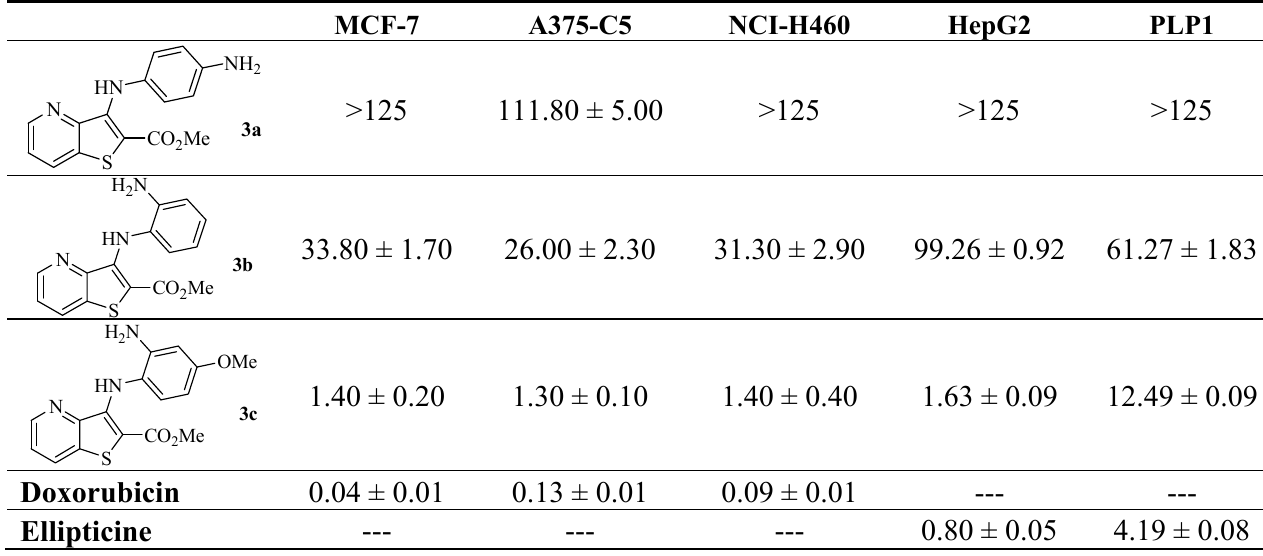
Table 1. GI values a (  M) for the aminodi(hetero)arylamines 3a – c and for the controls 50 doxorubicin and ellipticine (mean  SD; n = 3).